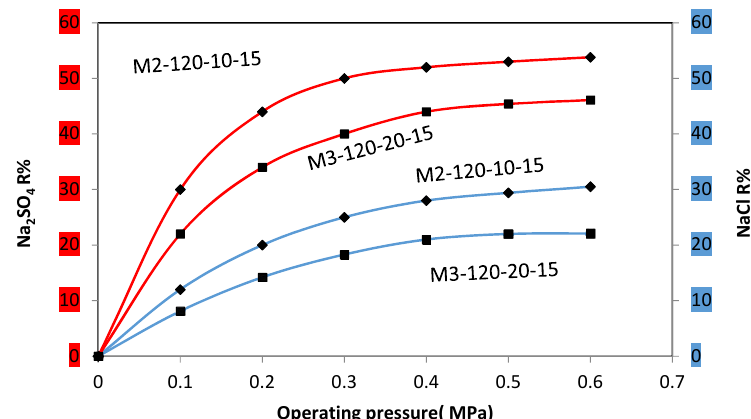
Fig. 9: Effect of operating pressure (MPa) and dip-coating parameter on the Rejection%.